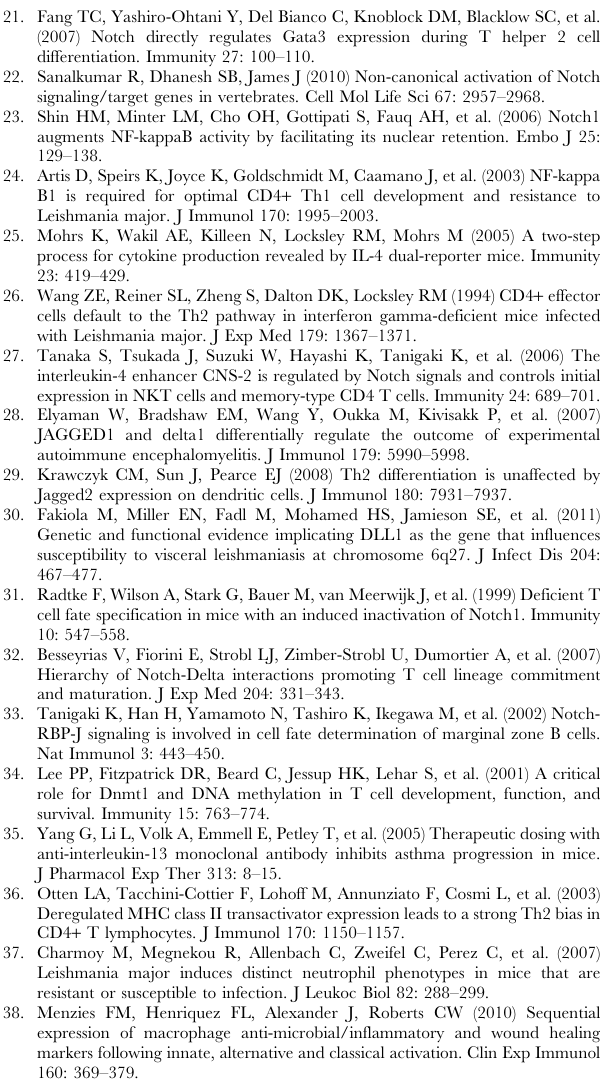
ELISA. A representative experiment of five is shown. n.d. not detectable. * p-value , 0.05 versus control mice. Figure S3 Impaired Th1 cell development in N1N2 D CD4Cre mice is not dependent on the L. major parasite strain. N1N2 D CD4Cre and control N1N2 lox/lox mice were infected s.c. with 3 6 10 6 L. major promastigotes of L. major Friedlin (A) or IR75 (B) and LV39 (C) strains. 6 weeks after infection, CD4 + T cells were isolated, restimulated or not with UV-irradiated L. major Friedlin (A), IR75 (B) or LV39 (C) in presence of irradiated spleen cells, and 72 hours later, IFN c and IL-13 secretion was quantified in supernatants. Mean cytokine secretion 6 SEM are given (n $ 3 mice per group). (D) The intralesional parasite load was assessed by LDA 6 weeks post infection with L. major Friedlin and IR75. Mean number of parasite per lesion is represented 6 SEM for n $ 3 mice per group. Data are representative of at least 3 individual experiments. * p- value , 0.05 versus control mice.